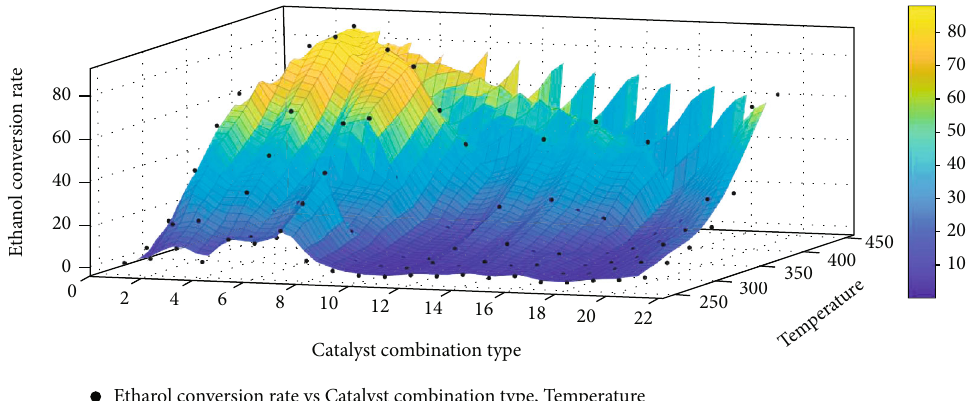
Figure 4: Spatial distribution of ethanol conversion rate.